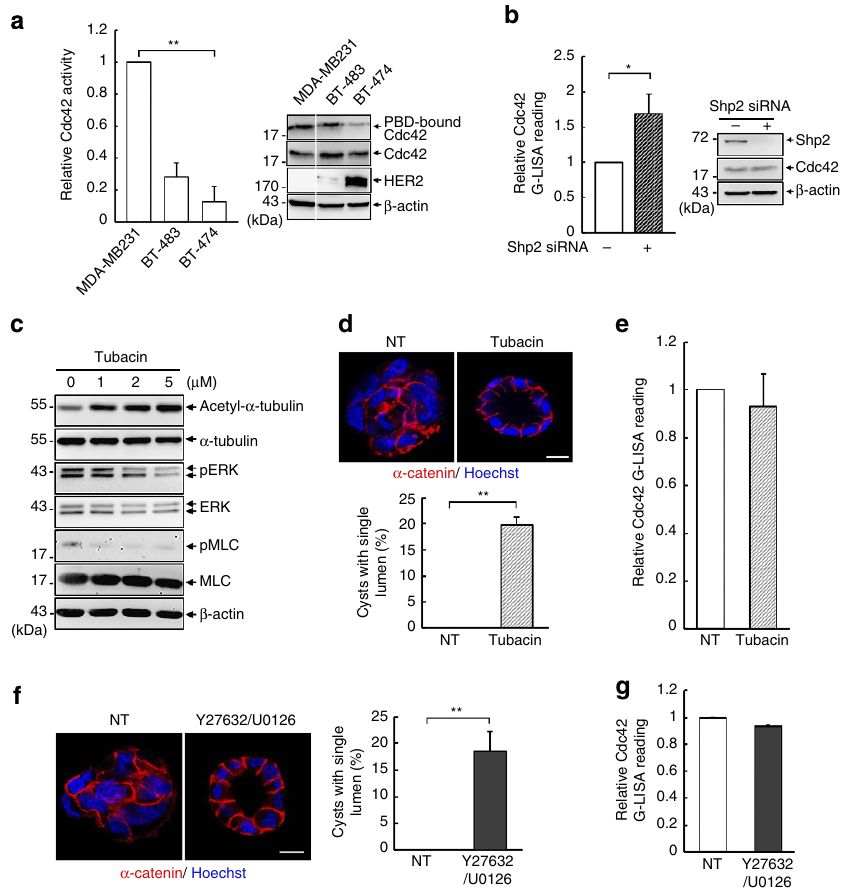
Figure 7 | Shp2 and HDAC6 influence epithelial organization of HER2-positive breast cancer cells. ( a ) Various breast cancer cell lines were lysed and subjected for Cdc42 activity assay by GST-PBD pull-down. Relative endogenous Cdc42 activity from three independent experiments is shown. Statistical significance was analysed by two-tailed unpaired Student’s t -test. * P o 0.05, ** P o 0.01. ( b ) BT474 cells were transfected with Shp2 siRNA, and then harvested for Cdc42 activity assay. Data are presented as mean ± s.d.; statistical significance was analysed by 2-tailed unpaired Student’s t -test. * P o 0.05, ( c ) BT474 cells were daily treated with Tubacin at the indicated concentration for 2 days, and harvested for western blot analysis. ( d ) Cells were cultured in Matrigel with daily treatment of tubacin (5 m M) for 2 weeks. These cysts were extracted for IF staining with anti- b -catenin (red) and Hoechst (blue). Percentage of cysts with single lumen (300 cysts were counted, n ¼ 3)Were analysed by two-tailed unpaired Student’s t -test. ** P o 0.01. ( e ) Cdc42 activity was analysed in 2 days of cysts. ( f ) BT474 cells treated with or without Y27632 (10 m M) and U0126 (10 m M) for 2 weeks were extracted for IF